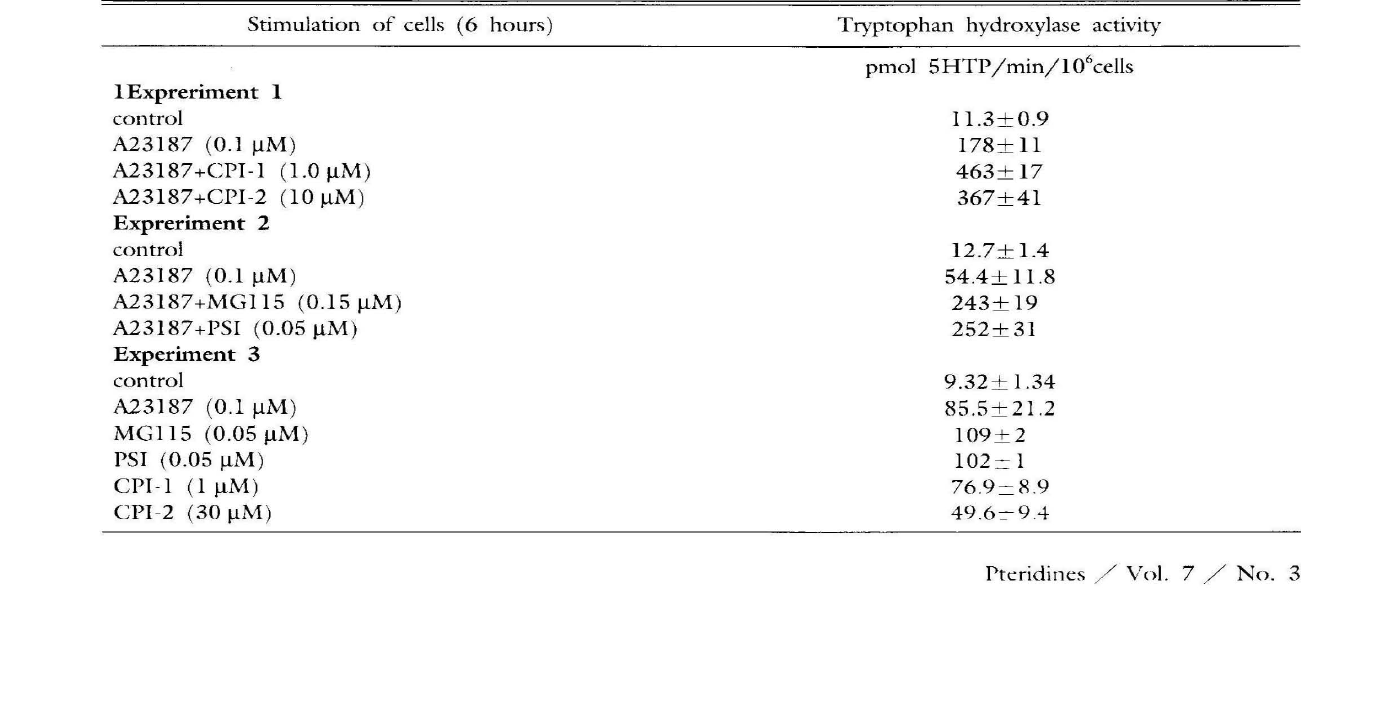
Table 1. Increase in Tryptophan Hydroxylase in the presence of A23187 and Protease Inbibitors: RBL2H3 cells \\-ere kept as monolayer culture (10' cells/ well in a 96-well microassay plate). Cells were treated with the indicated reagent for 6 hours. Then tryptophan hydroxylase activity was measured of disrupted cells by freezing and thawing for 2 times. Enzyme activity was expressed as 5HTP formation under standard assay conditions. Each experiment was con ducted with different cultures. AI; described previously, tryptophan hydroxylase activity at a resting stage was variable between cultures. Data given are means±S.E(n=4). CPI-l: Calpain inhibitor-I, CPI-2: Calpain inhibitor-2, MG115: carbobenzoxy-L-Leucyl-L-Leucyl-L-Norvalinal, PSI: carbobenzoxy-I1e-Glu( O-t-Bu )-A1a-leucinal. Stimulation of cells (6